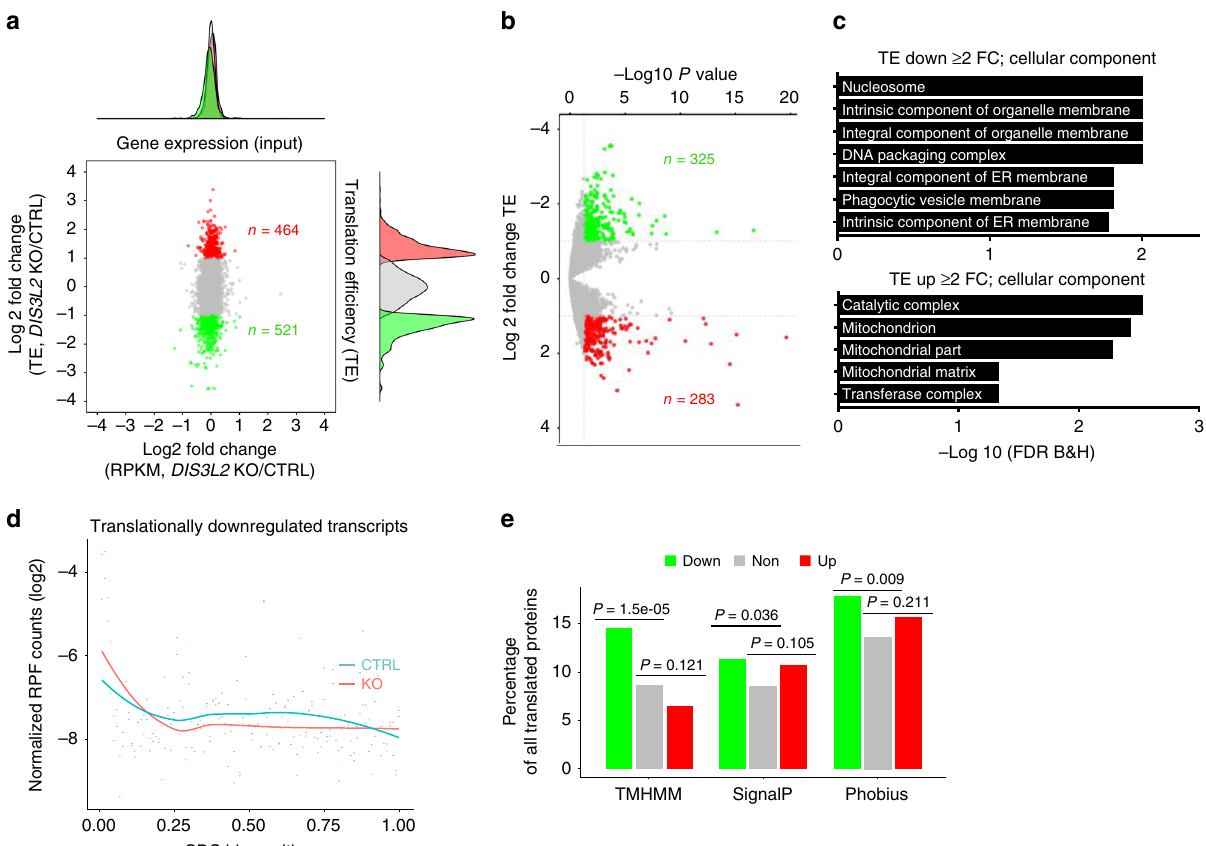
Fig. 1 Dysregulated ER-targeted mRNA translation upon DIS3L2 loss. a Scatter plot representing mRNA expression (input) and translation ef fi ciency [ribosome-protected fragments (RPFs) abundance in DIS3L2 knockout cells compared to heterozygote cells as control (CTRL)]. Translationally up- and downregulated genes ( ≥ 2-fold change) are marked in red and green, respectively. b Scatter plot representing signi fi cant perturbation of translation ef fi ciency upon DIS3L2 loss. P values are from two-sided Wald tests (DESeq2) and P value adjustments were made for multiple comparisons. c Gene ontology analysis of translationally dysregulated mRNAs in the DIS3L2 knockout mESCs. d Overall distribution of RPFs among translationally downregulated mRNAs. e Signi fi cant over-representation of transmembrane and/or signal sequences containing transcripts among translationally downregulated mRNAs ( P values are from two-sided Fisher ’ s exact